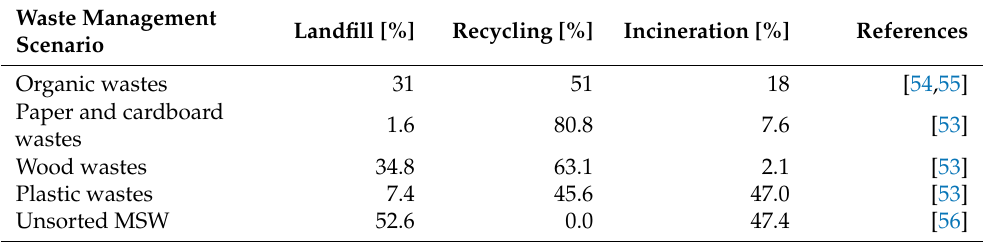
Table 5. Overall Italian waste management scenarios for packaging and organic wastes in 2019, as derived from the fresh pasta processing, distribution, and consumer